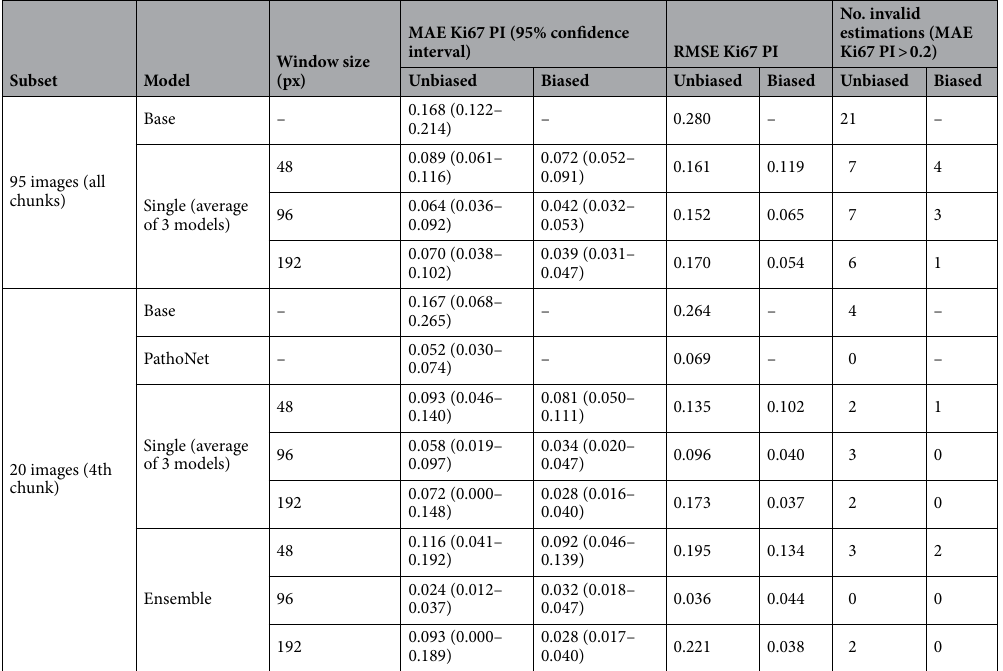
Table 2. The collective comparison of Ki-67 proliferation index estimations of the examined models. The presented values are averaged within the indicated subset. Due to non-negative values of MEA, the lower boundaries of confidence intervals are limited to 0. Each subset’s image was evaluated by models, which had not been trained on it (as described in the “Data”